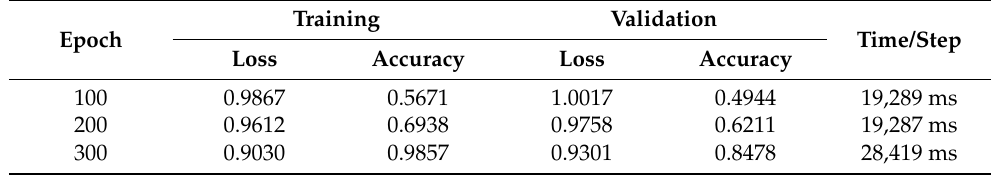
Table 2. Training and validation accuracy and training and validation loss in CNN